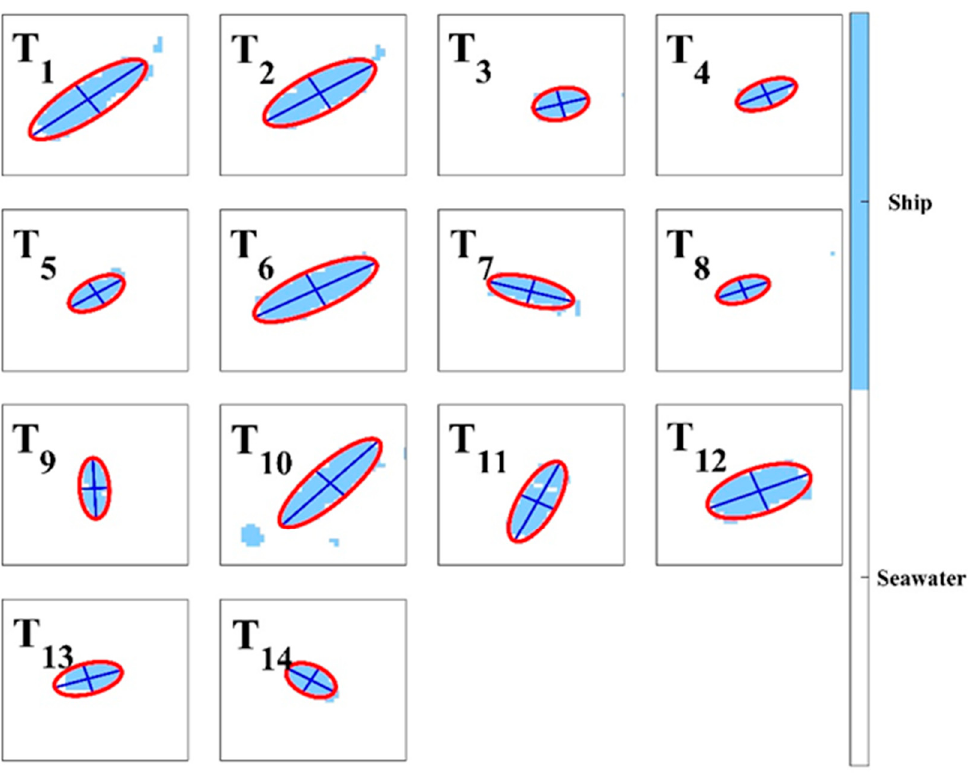
Figure 12. Spatial distribution of the vessels from T 1 to T 14 , marked in blue, and least-squared fitted ellipses along the boundary of the vessels.